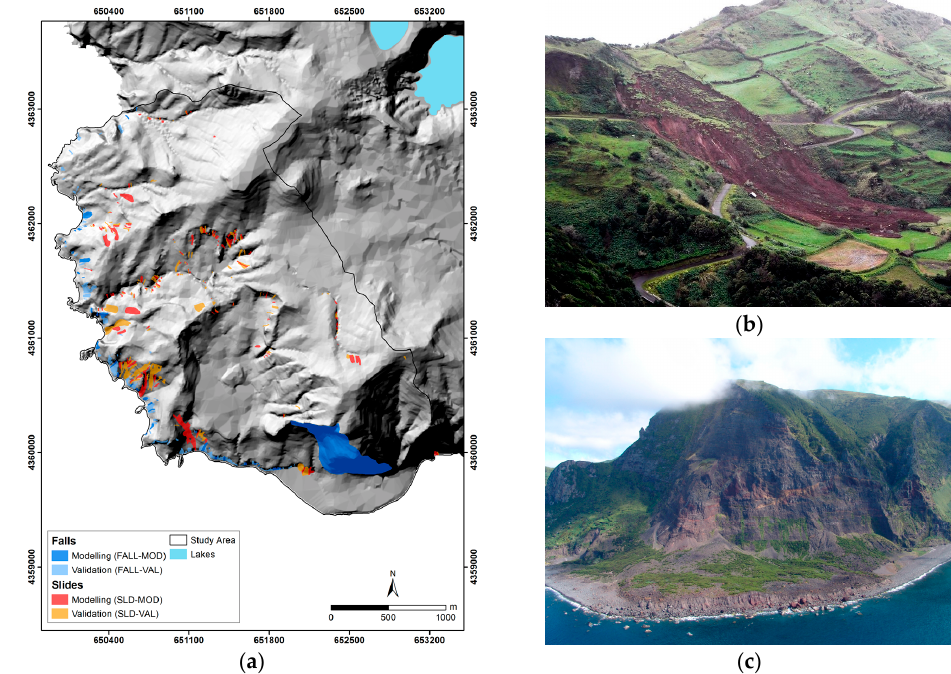
Figure 2. ( a ) Landslide inventory map; ( b ) Example of a slide at Lajedo (photo by the authors); ( c ) Example of a fall at Costa (photo by the authors).